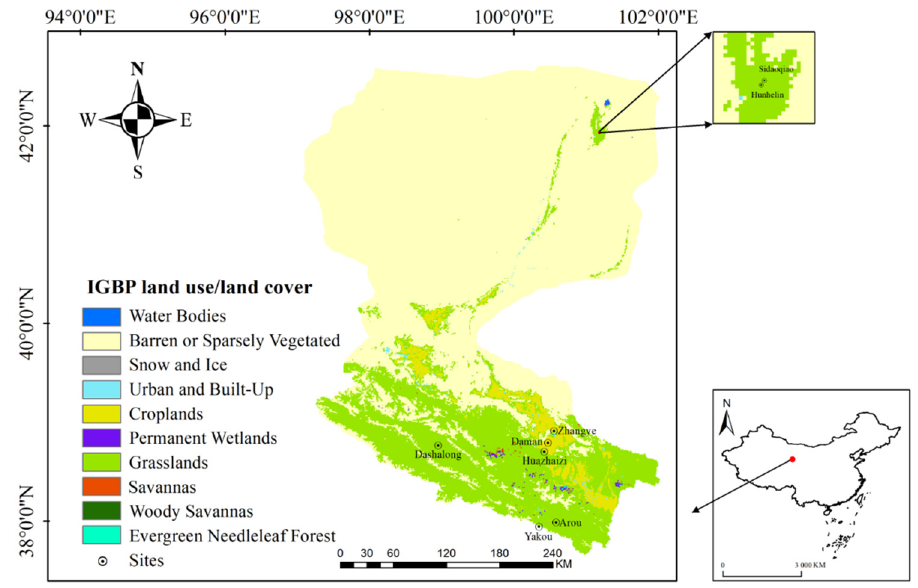
Figure 1. The land use types of the Heihe river basin and distribution of sites.